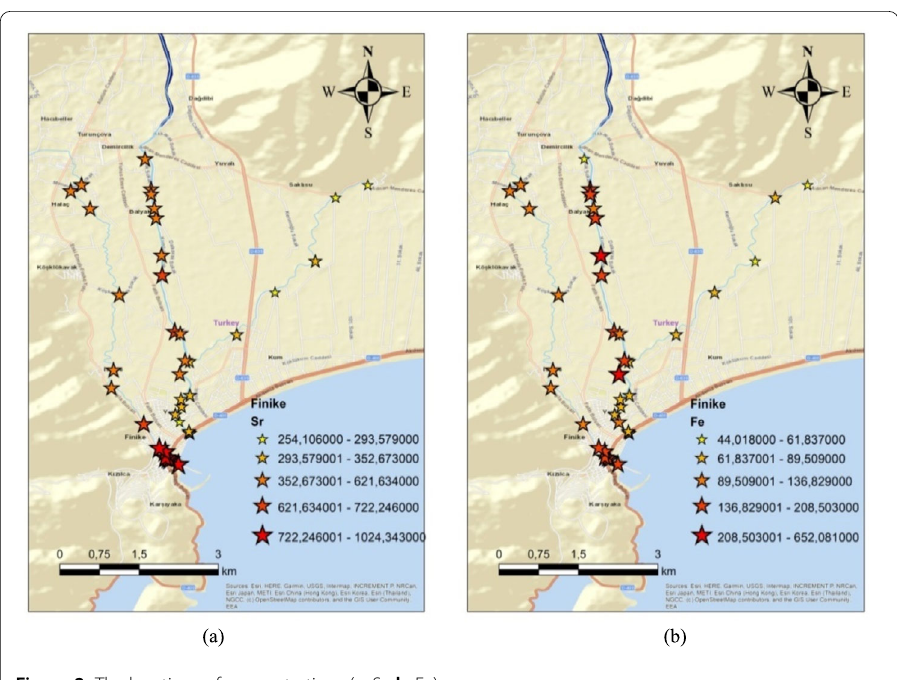
Figure 2 The locations of concentrations ( a : Sr; b :